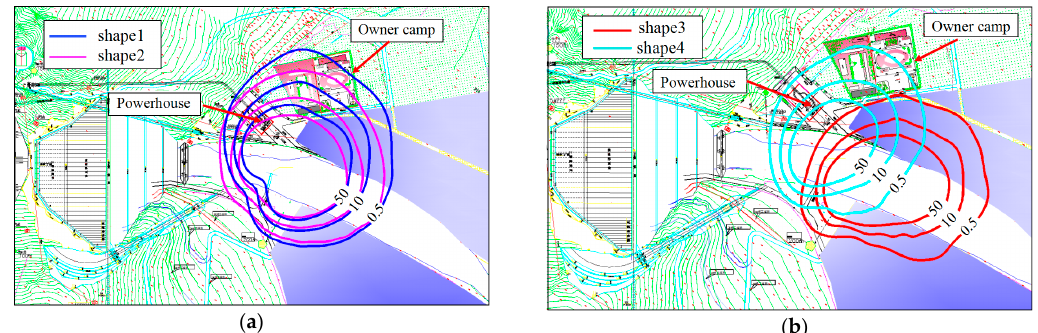
Figure 9. Rainfall intensity distribution of different bucket types of the prototype: (a) rainfall intensity distribution of shape 1 and shape 2; (b) rainfall intensity distribution of shape 3 and shape 4 (unit: mm h − 1 ).